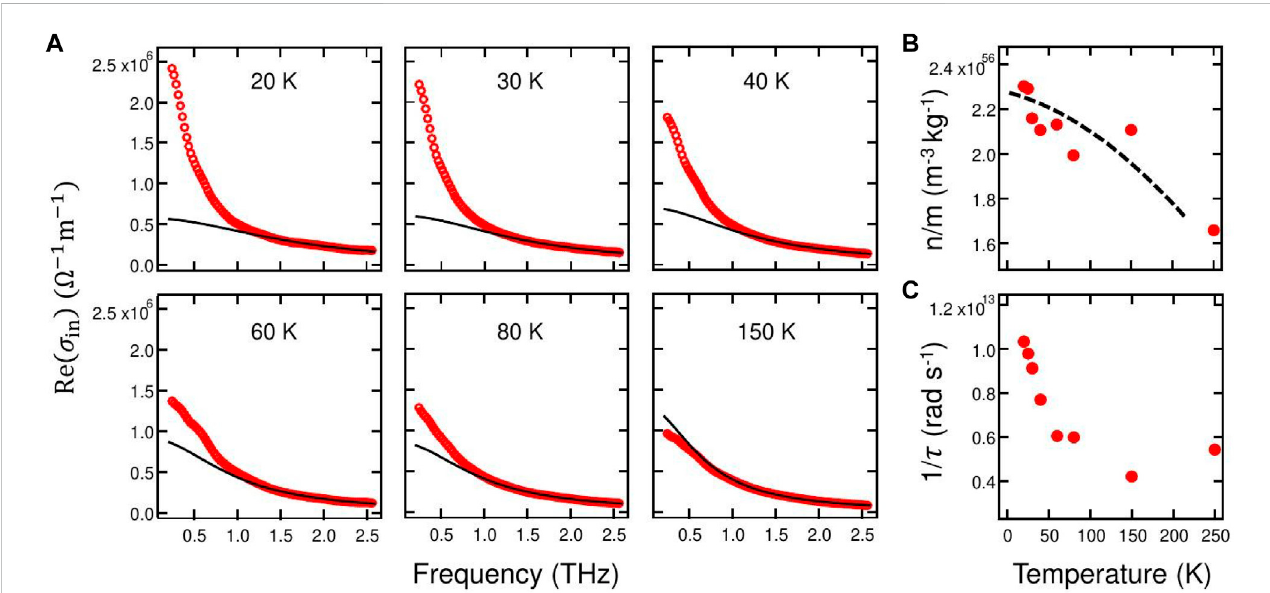
FIGURE 3 (A) Drude fi tstotherealpartoftheintrinsicopticalconductivityofYbRh 2 Si 2 atvarioustemperatures.Thesubtractionoftheresidualresistivityisdescribed in (Prochaska et al., 2020). The fi ts (black solid lines) are anchored to the high-frequency range of the experimental data (red circles). Strong deviations from Drudebehaviorareseenatlowfrequencies,inparticularforthelow-temperatureisotherms.Temperaturedependenceoftheratio n / m (B) andthescattering rate 1/ τ (C) extracted from the Drude fi ts. The black dashed line is a guide to the eyes for extrapolating the n / m value to T =